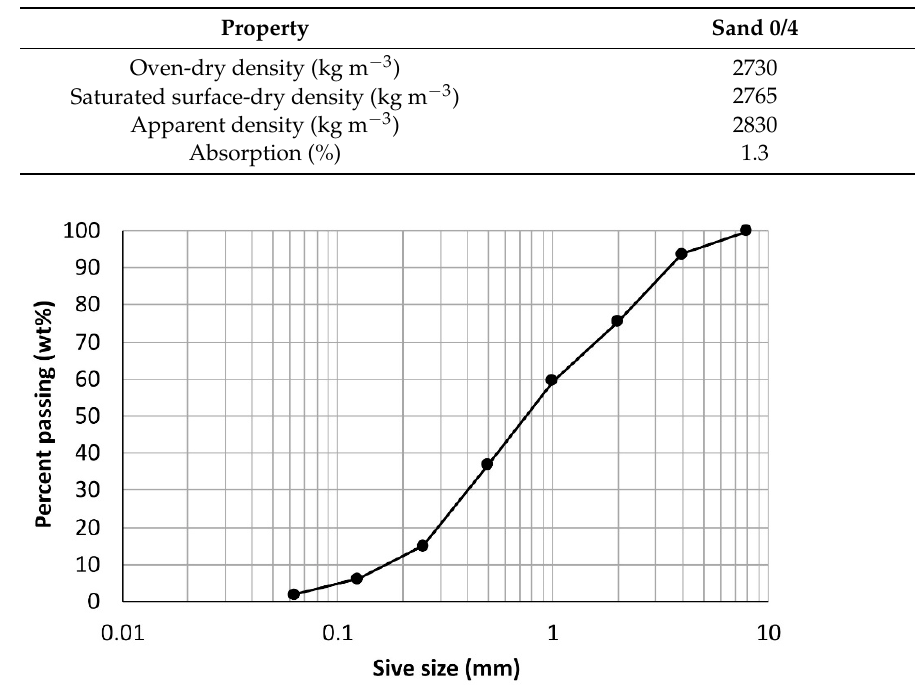
Figure 1. Particle size distribution of aggregate.